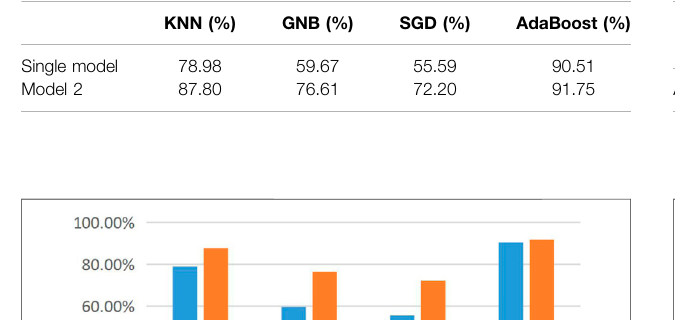
TABLE 6 | Classi fi cation accuracy of prediction results of different models. TABLE 7 | Data set classi fi cation accuracy table.